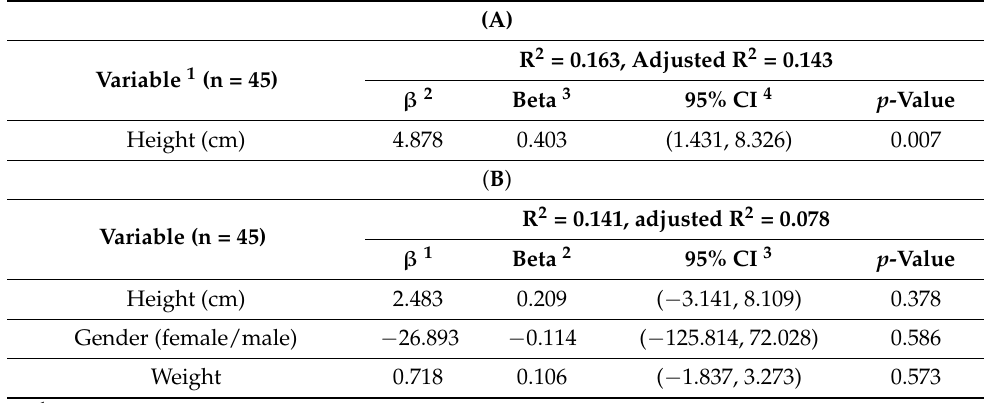
Table 5. ( A ). Factors affecting exhaled CO half-life in smokers. ( B ). Factors affecting exhaled CO half-life for